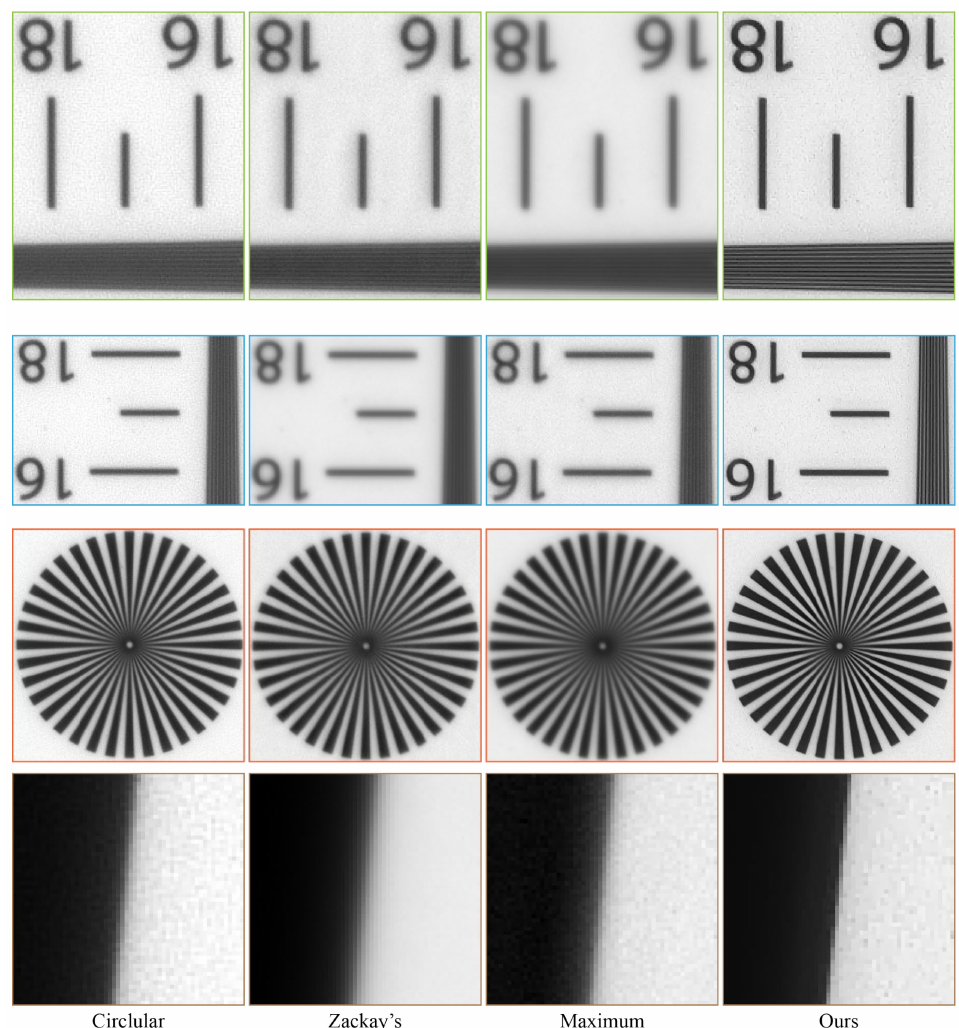
Figure 14. Visual comparison of different algorithms’ synthetic results. The areas marked with rectangles in Figure 13b are zoomed and outlined with the corresponding colors.